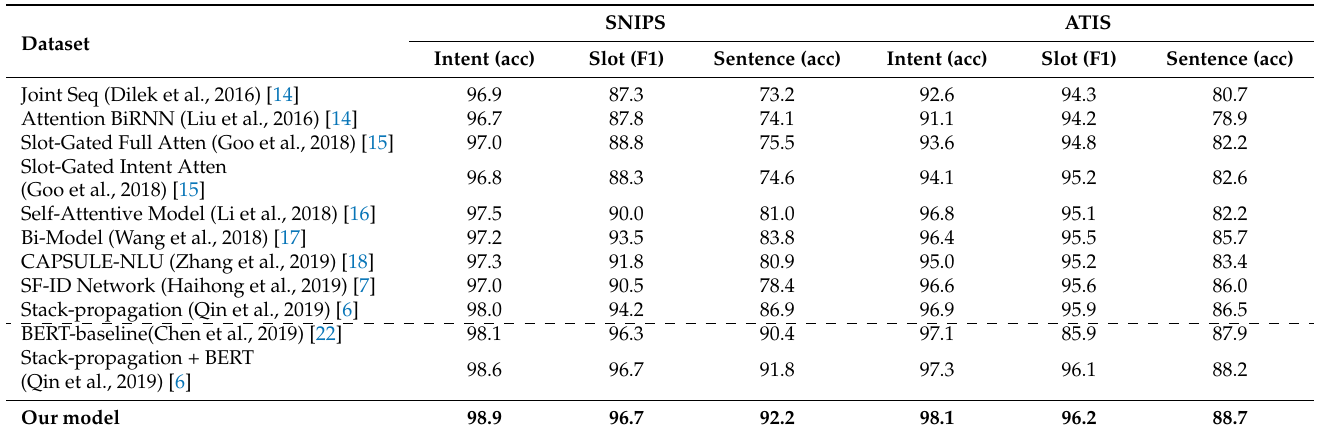
Table 4. Comparison of experimental results of different methods.